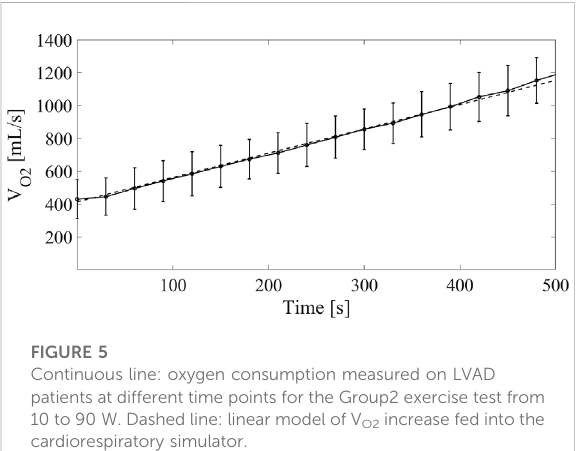
FIGURE 5 Continuous line: oxygen consumption measured on LVAD patients at different time points for the Group2 exercise test from 10 to 90 W. Dashed line: linear model of V O2 increase fed into the cardiorespiratory simulator.